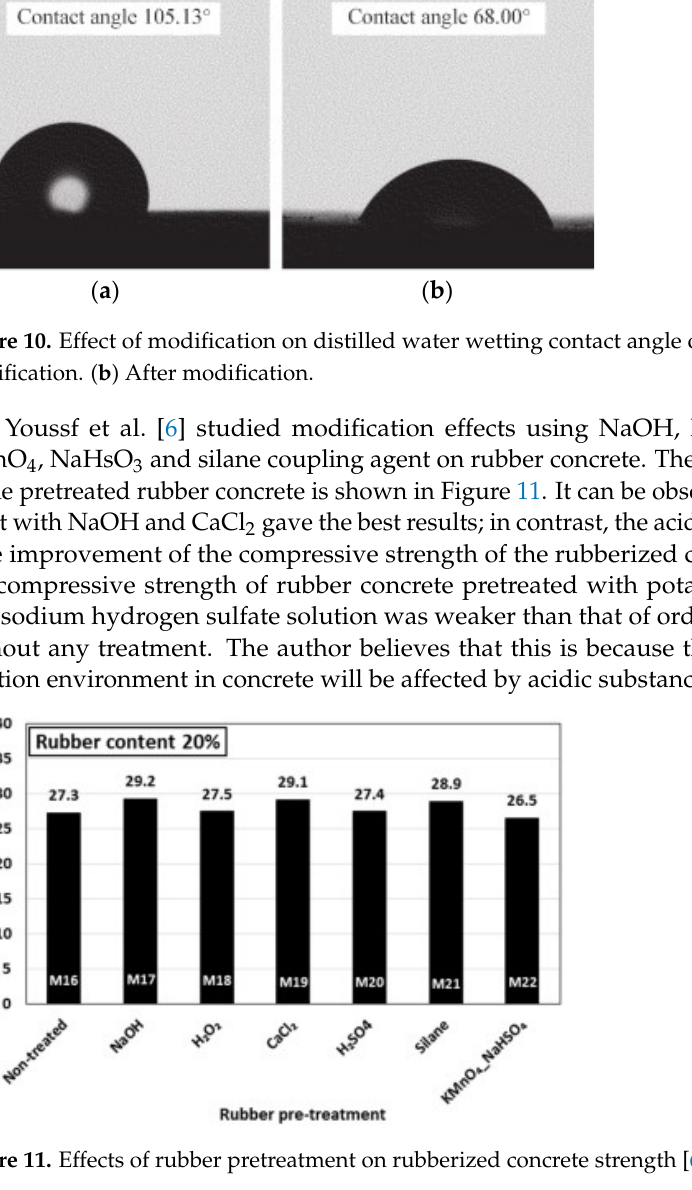
Figure 12. Schematic diagram of chemical modification of rubber surface and contact with cement paste. Pham et al. [10] Pretreated rubber with a copolymer composite coating and explored the performance of pretreated rubberized concrete in resisting freeze–thaw cycles. The test results showed that the anti-freeze–thaw cycle performance of the coated rubberized concrete was weaker than that of the original rubberized concrete, but the mass loss of both after the same freeze–thaw cycle was much higher than that of ordinary concrete. This shows that rubberized concrete has excellent resistance to freeze–thaw cycles and has application potential in cold regions. The residual compressive strength of the rubberized concrete after freeze–thaw cycles was higher than that of the untreated rubberized con- crete. This shows the excellent performance of rubber concrete in terms of concrete dura- bility. The test results are shown in Figures 13 and 14. The author believes that the results were determined by the characteristics of the rubber itself. The stable expansion and